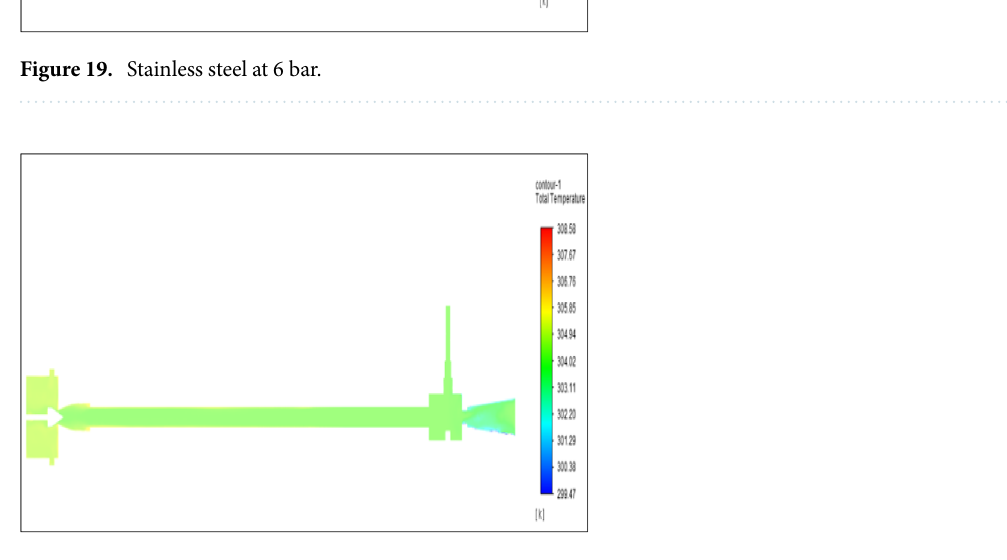
Figure 20. Brass at 6